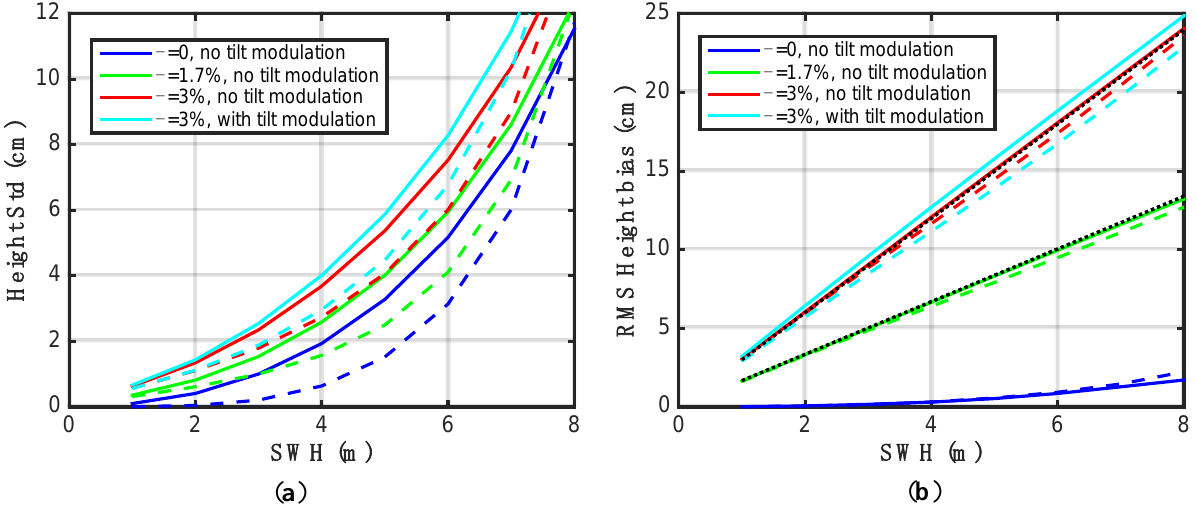
Figure 4. Swath average height standard deviation ( a ) and bias ( b ) as a function of SWH for unidirectional ocean wave field following the Pierson-Moskowitz spectrum for waves aligned with the boresight (0 deg) in solid and the along track (90 deg) directions in dashed, computed using radar simulations for the Surface Water and Ocean Topography (SWOT) geometry, radar parameters and on board radar processing. Four cases of brightness modulation are assumed, 𝛽 = 0 and no tilt modulation in blue, 𝛽 = 1.7% and no tilt modulation in green, 𝛽 = 3% and no tilt modulation in red and 𝛽 = 3% and including tilt modulation in cyan. The dotted black lines in (b) correspond to the theoretical expression in Equation (9) for 𝛽 = 1.7% and 𝛽 = 3%